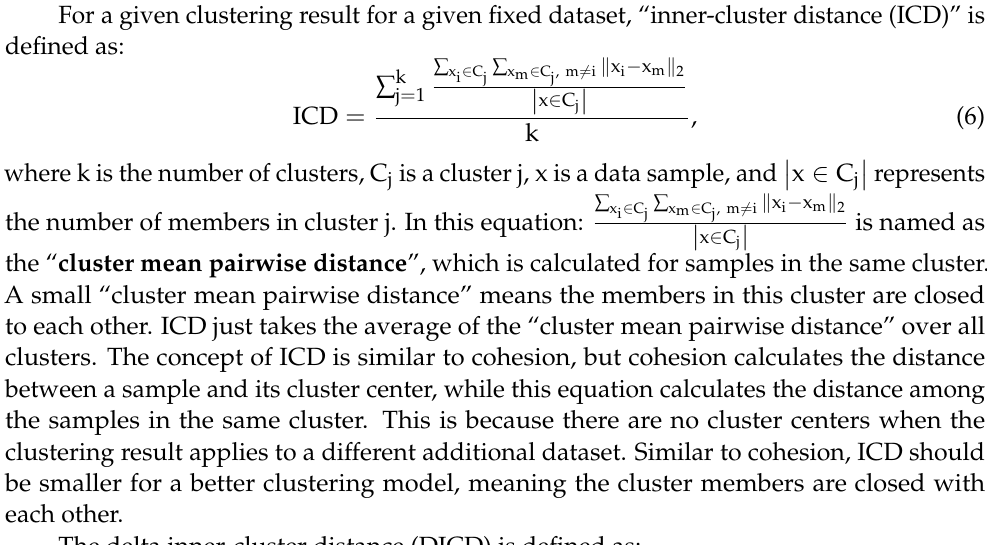
Figure 3. An example of using an existing clustering result applying to additional new data (this is the hypothetical result with only five samples for demonstration